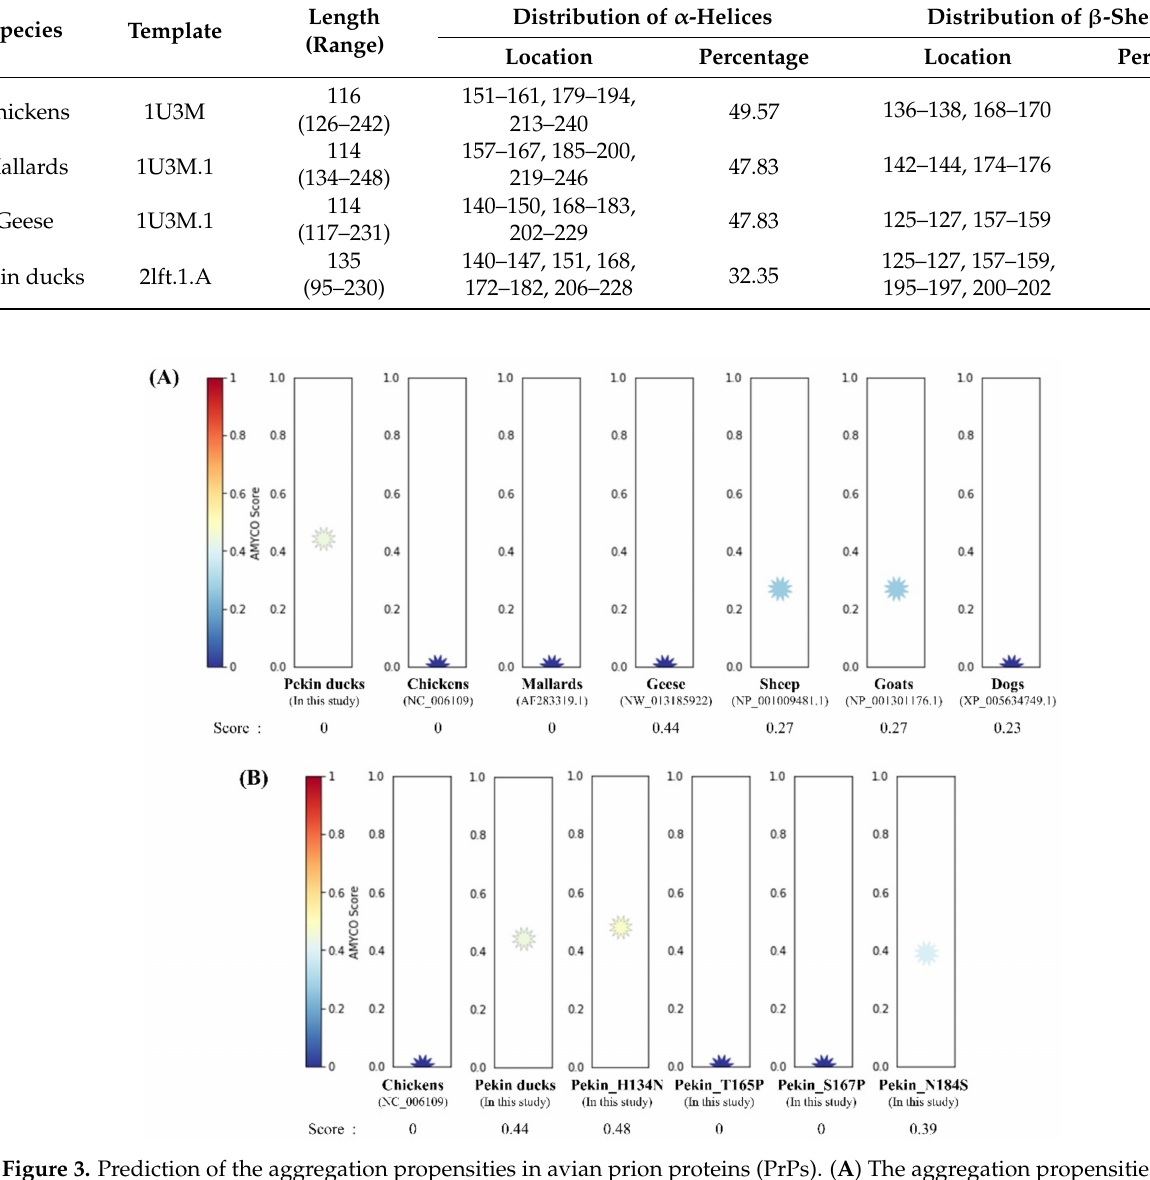
Figure 3. Prediction of the aggregation propensities in avian prion proteins (PrPs). ( A ) The aggregation propensities into amyloid structures in the PrPs were predicted by AMYCO. The text in parentheses indicates protein IDs of the reference sequences used for AMYCO analyses. ( B ) The aggregation propensities according to the substitution with chicken-specific amino acids in the Pekin duck PrP using AMYCO. Pekin_H134N indicates the AMYCO result according to the substitution of His at codon 134 to Asn in the Pekin duck PrP. Pekin_T165P indicates the AMYCO result according to the substitution of Thr at codon 165 to Pro in the Pekin duck PrP. Pekin_S167P indicates the AMYCO result according to the substitution of Ser at codon 167 to Pro in the Pekin duck PrP. Pekin_N184S indicates the AMYCO result according to the substitution of Asn at codon 184 to Ser in the Pekin duck